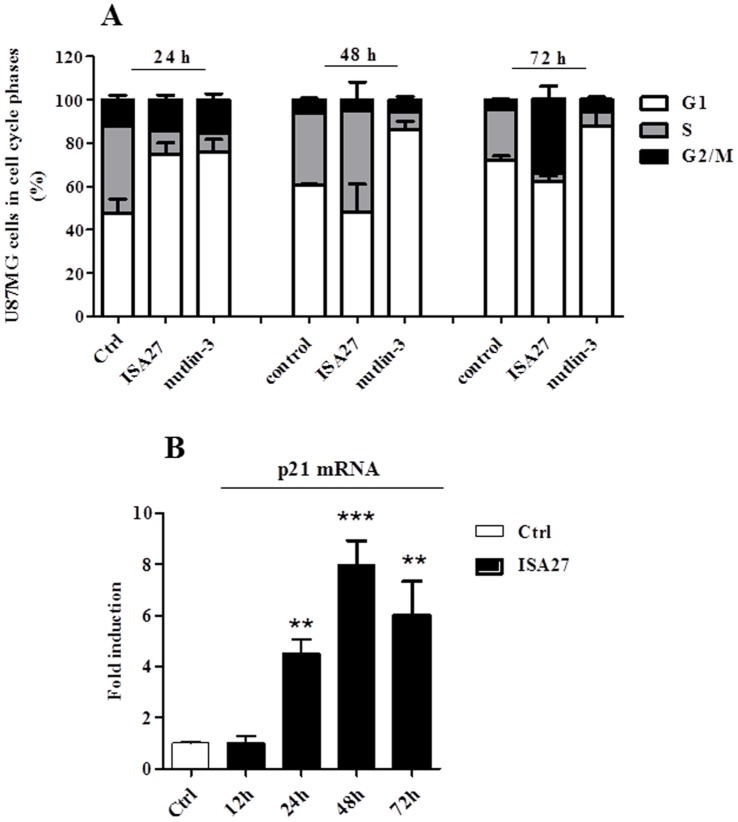
Long-term ISA27 treatment induces cell cycle arrest and a persistent increase in p21 mRNA levels in U87MG cells.
7A) Flow cytometric cell cycle profiling: the figure shows the percentage of untreated and MDM2 inhibitor-treated U87MG cells in G1-, S- and G2/M-phase. 7B) p21 mRNA evaluation: ISA27 treatment resulted in a statistically significant increase in p21 mRNA levels at 24, 48 and 72 h.